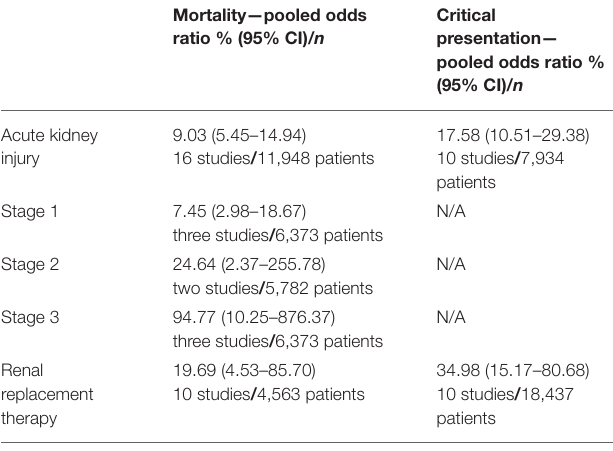
TABLE 2 | Prognosis associated with renal manifestations. Mortality—pooled odds ratio % (95% CI)/